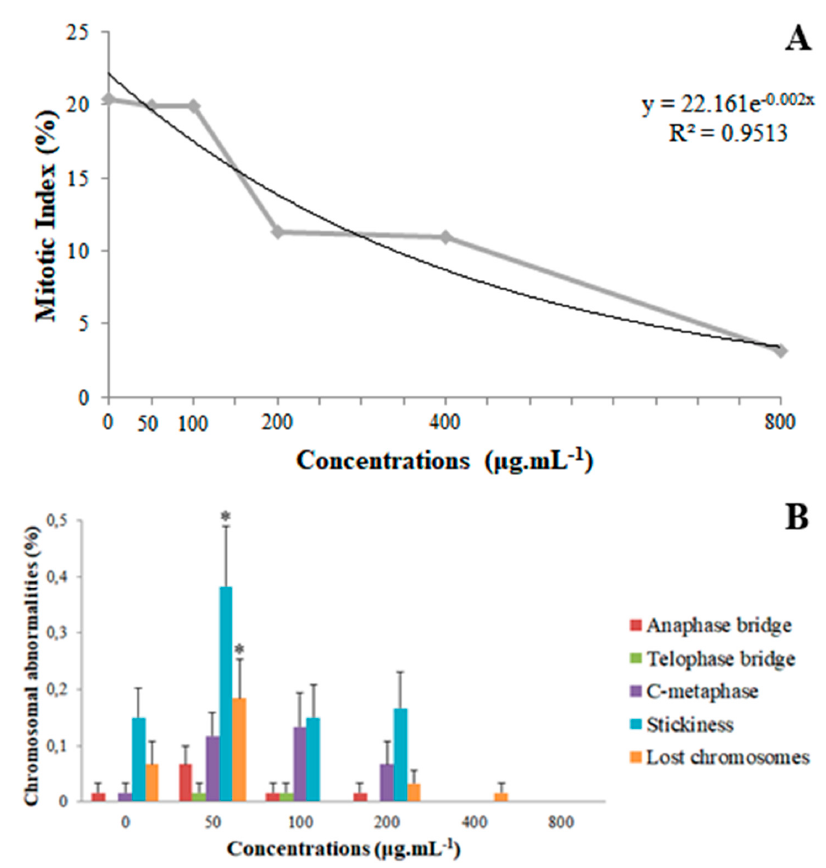
Figure 3. Cytogenotoxicity parameters. ( A ) Quadratic regression of averages of Mitotic index (MI) for the root tips of Lactuca sativa exposed to di ff erent concentrations of coumarin 8-methoxy-2-oxo-6- (prop-2-en-1-yl)-2H chromene-3-carboxylic acid (A1). ( B ) Frequency of chromosomal abnormalities, in percentage, identified in the meristematic zone of Lactuca sativa roots exposed to the di ff erent concentrations of coumarin 8-methoxy-2-oxo-6-(prop-2-en-1-yl)-2 H -chromene-3-carboxylic acid (A1). Columns with same collor followed by asterisks (*) di ff er statistically by the Scott–Knott test at 5% significance. Bar: standard